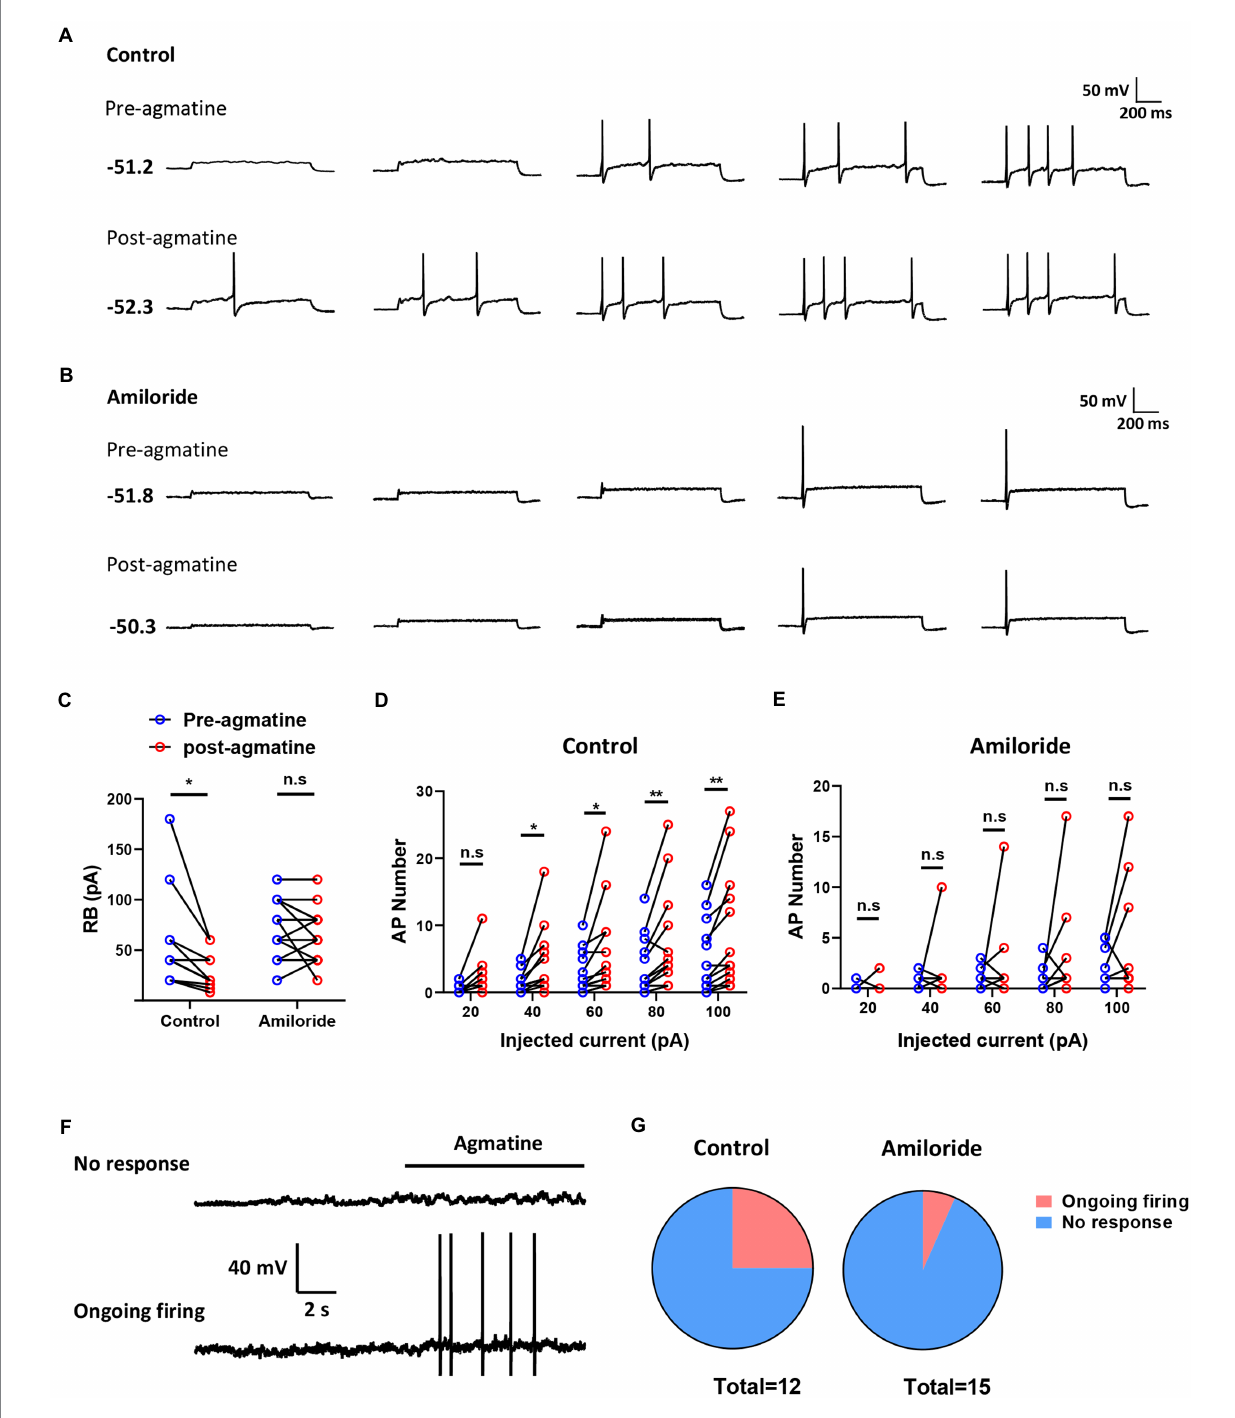
FIGURE 5 Agmatine induced spontaneous action potentials in some small-sized DRG neurons. (A,B ) Examples of action potential (AP) traces evoked by current injection pre- and post-agmatine perfusion in small DRG neurons from control (A) and amiloride pre-incubation (B) groups. (C) Rheobase pre- and post-agmatine perfusion in small DRG neurons (* p < 0.05 post- vs. pre-, paired Student’s t test: n = 12 in control group, n = 15 in the amiloride pre- incubation group). (D,E) The number of APs pre- and post-agmatine perfusion in small DRG neurons (* p < 0.05, ** p < 0.01 post- vs. pre-, two-way ANOVA following Bonferroni’s test: n = 12 in control group, n = 15 in the amiloride pre-incubation group). (F) Examples of traces during agmatine perfusion. (G) The proportion of DRG neurons exhibited ongoing firing during agmatine